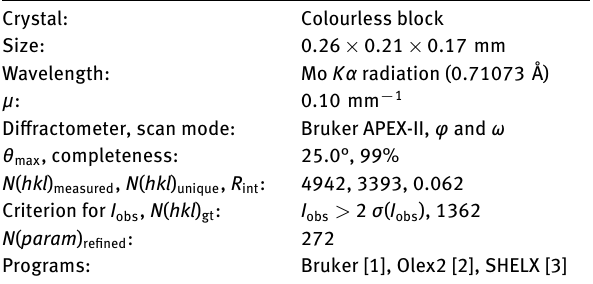
Table 2: Fractional atomic coordinates and isotropic or